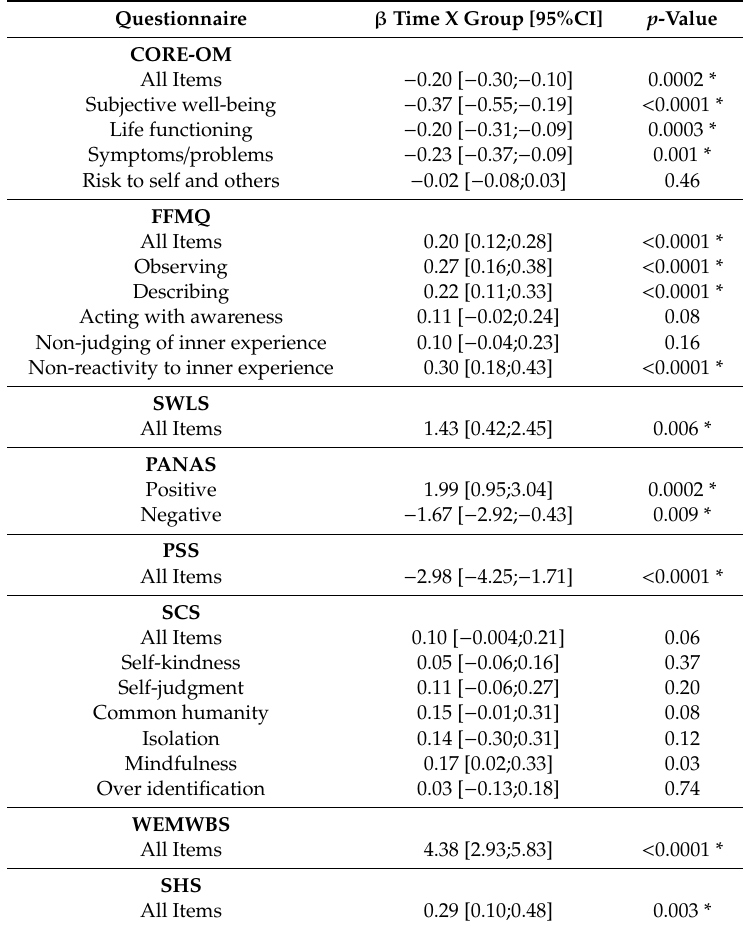
Table 3. Linear mixed model results. For each questionnaire and subscale β coe ffi cient of time*group interaction with its 95% CI, and p -value are